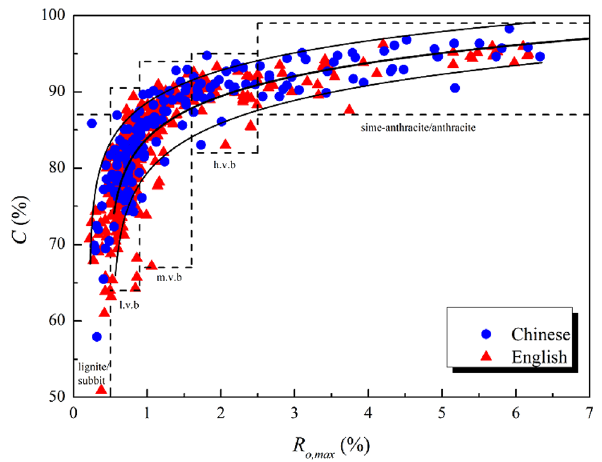
Fig. 11 Variation of C content with vitrinite reflectance R o ; max . (Data size: Chinese (Ceglarska-Stefan´ska and Brzo´ska 1998; Chang et